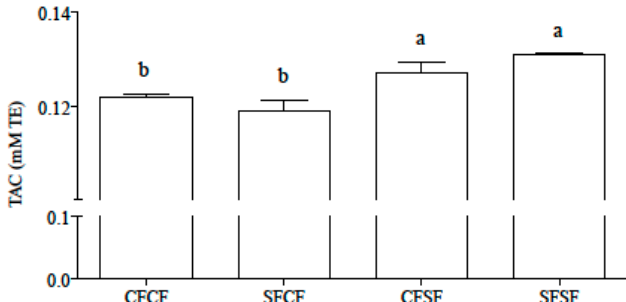
Figure 1. Total antioxidant capacity (TAC) in L3 hydrolysates. Results are expressed as mM Trolox Equivalent (TE) and are means ± SD of triplicate determination. Statistical analysis was by one-way ANOVA ( p < 0.001), using Tukey’s post-hoc test. Different letters indicate statistically significant differences (at least p < 0.05).